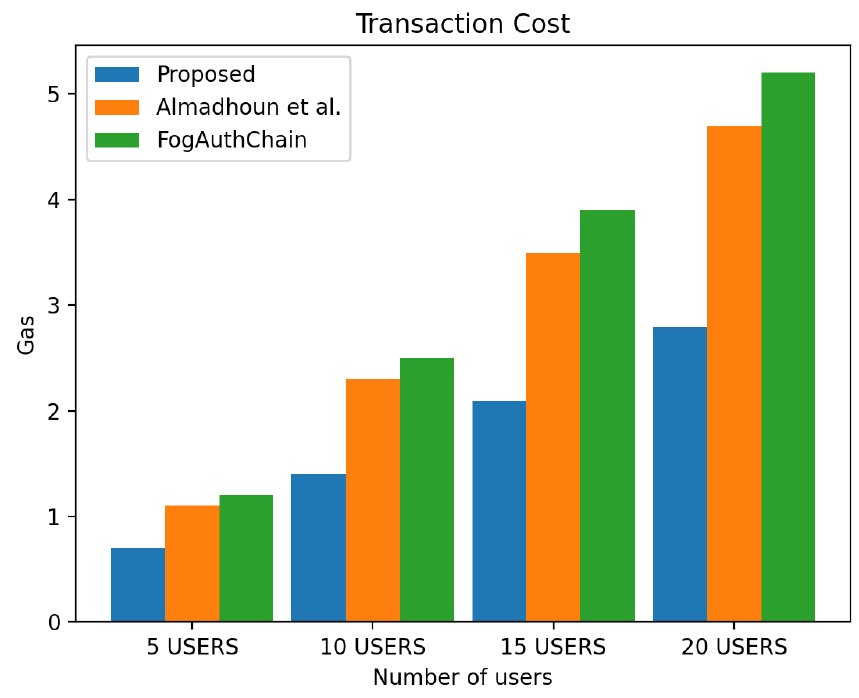
Figure 7. Comparison of experimental results of the proposed system and existing systems (Almad- houn et al. [36] and FogAuthChain [1]) on registration transaction